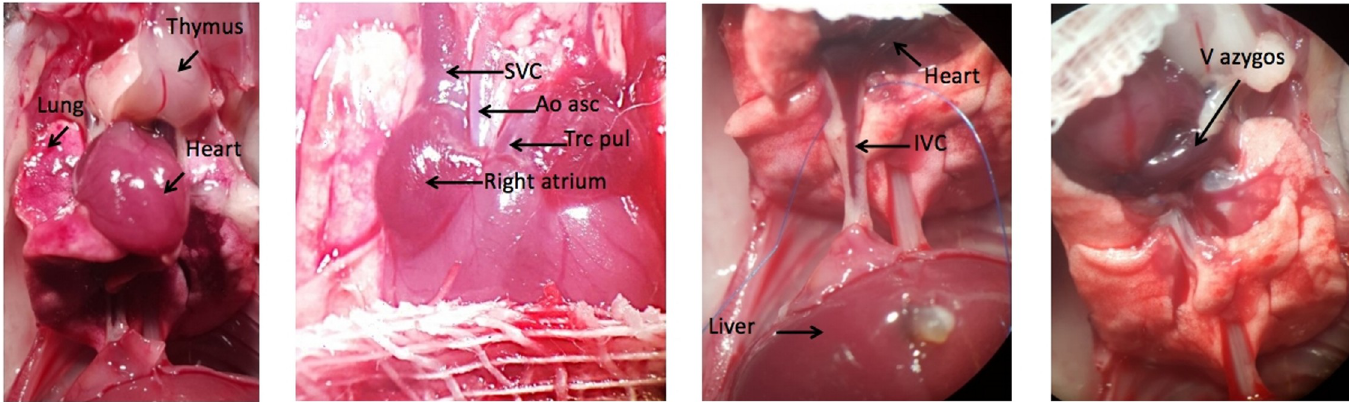
Fig 2. a-d: Photographic illustrations of the donor operation . Fig 2A shows the donor heart in-situ with the thymus turned upwards. Fig 2B is a close-up of the heart and its superior vessels: the superior vena cava (SVC), ascending aorta (Ao asc). The SVC is being ligated, the Ao asc is transected just below the brachiocephalic artery, and the pulmonary artery (Trc pul) is transected just below its bifurcation. Fig 2C shows the inferior vena cava (IVC) before its ligation. Fig 2D shows the azygos vein, which is also being ligated, together with the pulmonary